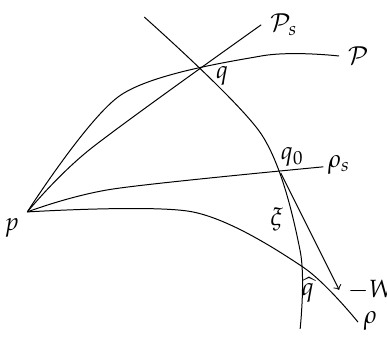
Figure 4. Riemannian and Finsler geodesics in Zermelo’s navigation